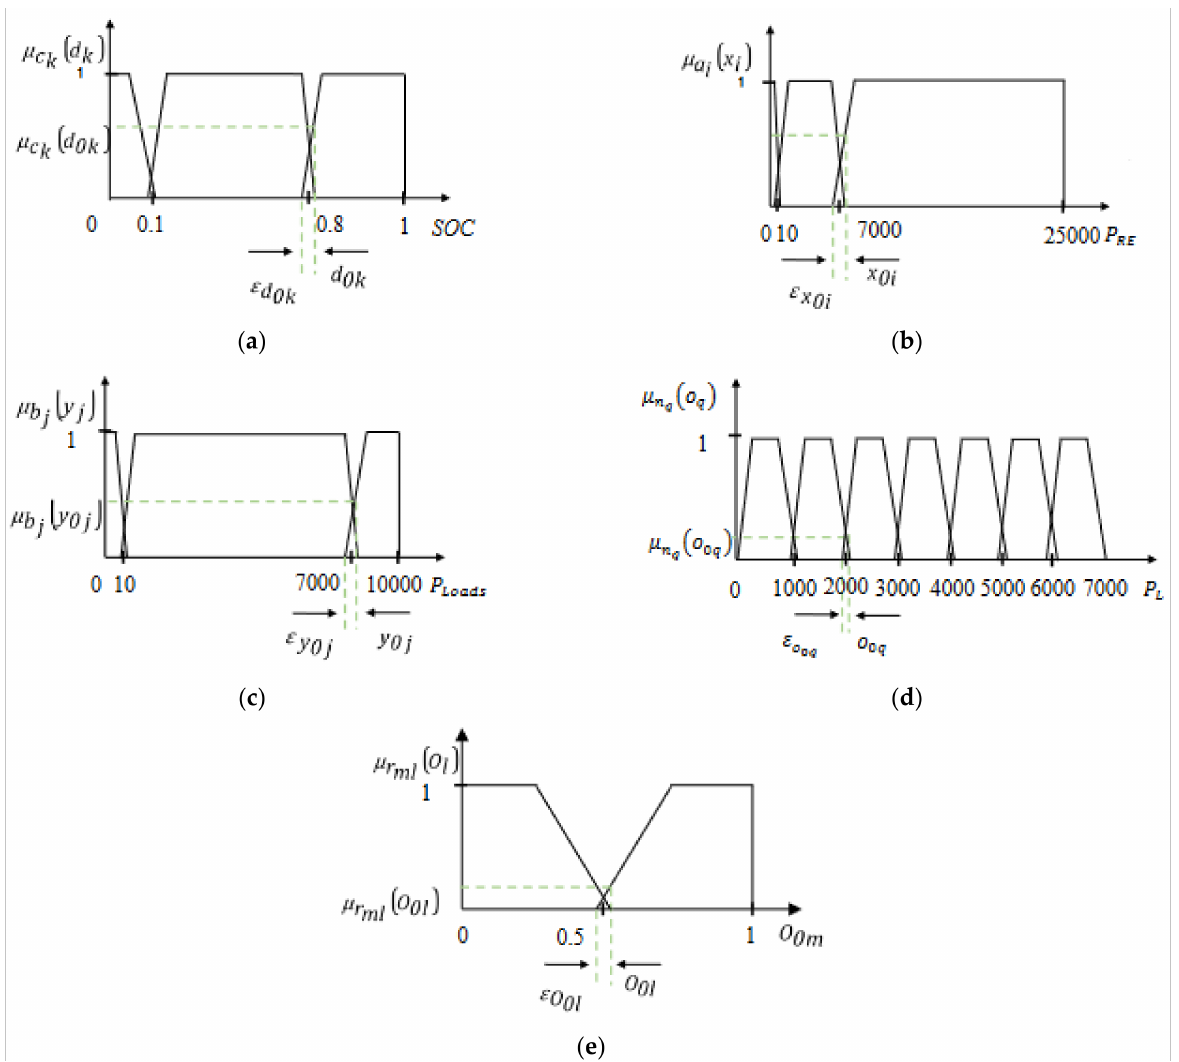
Figure 3. The membership functions corresponding to: ( a ) RE power P RE , ( b ) Battery SOC , ( c ) Power demand P Loads , ( d ) Power each load P L , and ( e ) Switching orders of the